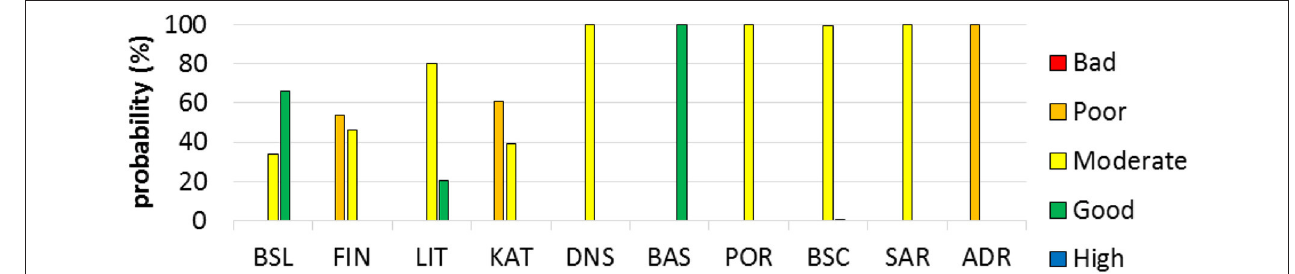
FIGURE 3 | Probabilities for the five environmental status classes for each of the 10 case study assessments. Good environmental status is assumed attained if the cumulative probability of “Good” and “High” is higher than the cumulative probability of “Moderate,” “Poor,” and “Bad.” If opposite, the Good environmental status is not attained. For case study codes see Table 1